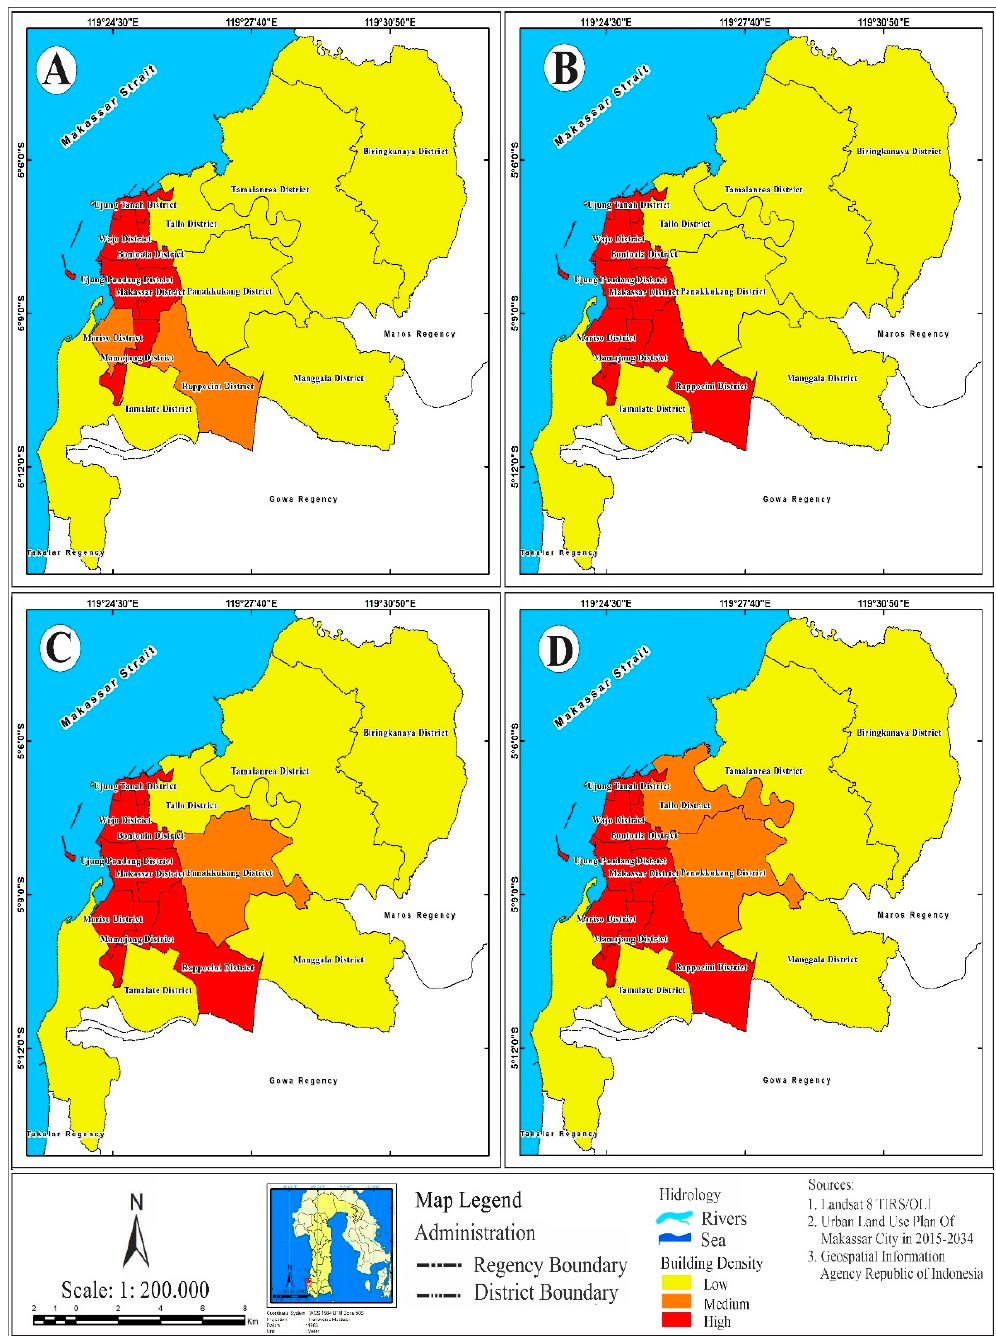
Figure A2. Comparison of building density in Makassar City: ( A ) 2006, ( B ) 2009, ( C ) 2016, and ( D ) 2020.